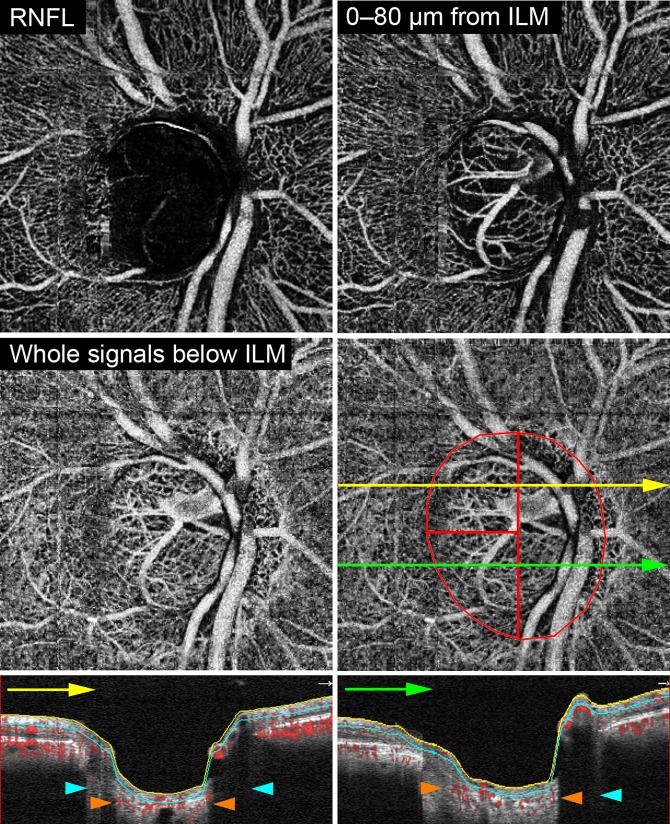
Optical coherence tomography angiography (OCTA) microvasculature images of optic nerve head in glaucoma eye without microvasculature dropout inside the optic disc.OCTA en face projection images in the retinal nerve fiber layer (RNFL) (Top left), superficial layer (Top right), and the whole-depth (Second row). The red ellipse indicates the optic disc boundary and red lines show the boundaries of evaluation areas. Superotemporal and inferotemporal regions were used for evaluation of microvasculature dropout. The yellow and green lines indicate the location of the B-scans in the bottom row. Bottom, Cross-sectional angiogram images overlying the B-scan images. Microvasculature in the anterior portion of lamina cribrosa is visualized in the area shown by orange arrowheads, while the anterior lamina cribrosa and microvasculature cannot be detected because of vessel shadowing in the area shown by aqua arrowheads. Yellow and aqua borders show the inner limiting membrane (ILM) and 80 μm below the ILM, respectively.